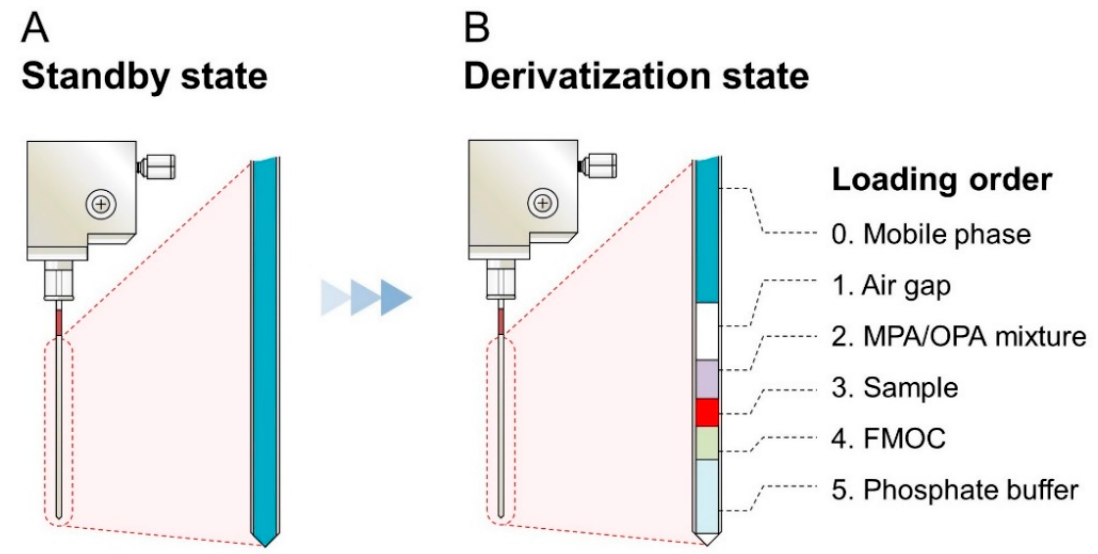
Figure 2. Diagram showing the contents of the needle with the amino acid derivatization using the iPDAQ. ( A ) State of the needle before the start of the derivatization procedure. ( B ) Function of the air gap and the loading order of the sample and derivatization regents.